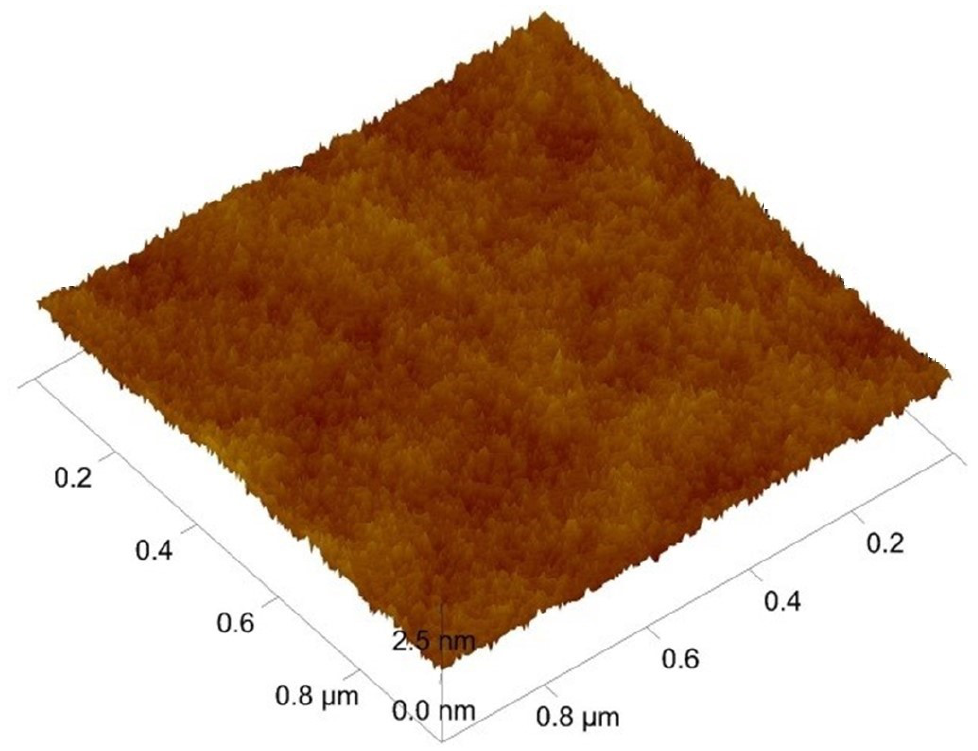
Figure 2. The AFM image (3D) of the unannealed WC/C coating.